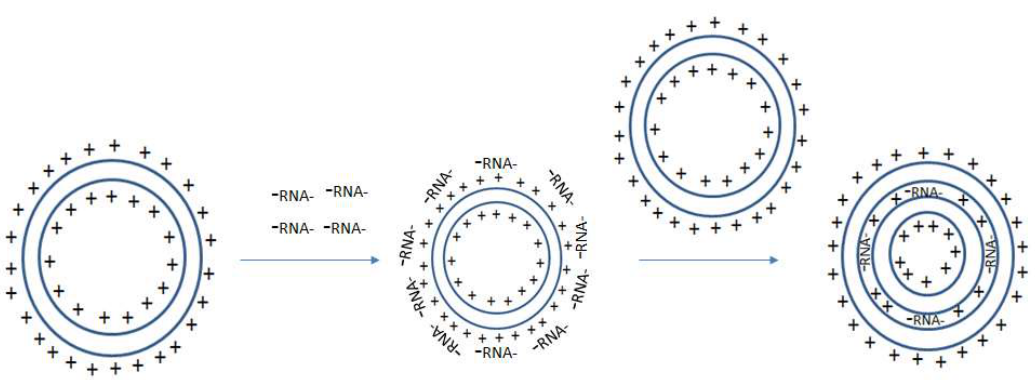
Figure 1. Proposed Schema for RNA-liposome encapsulation: A bilamellar lipid particle with a positively charged surface and inner core electrostatically interact with negatively charged RNA. Negatively charged RNA coats the surface of the bilamellar lipid particle, which electrostatically interacts with a new positively charged bilamellar lipid particle. The new positively charged bilamellar lipid particle complexes with the original RNA coated bilamellar lipid particle. This forms a multilamellar particle where the RNA is trapped between the two layers of the lipid particles.